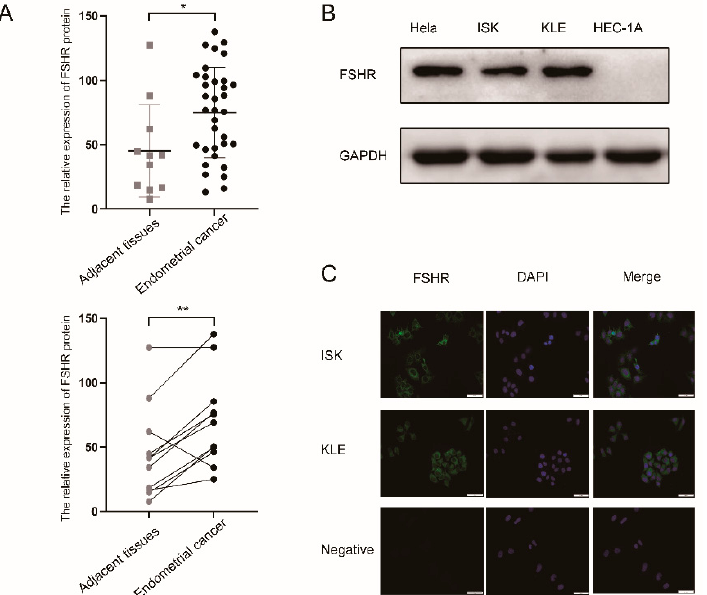
Figure 1. Expression of FSHR in EC tissue and cell lines. ( A ) Detection of the expression of FSHR in EC tissues and adjacent tissues by IHC. In the formula Histochemistry scores = ∑ ( PI × I ) , PI is the proportion of positive cells among all cells in the section and I corresponds to the color intensity of a section. ( B ) FSHR was detected by Western blot (WB) in the Hela cell line, as well as the ISK, KLE, and HEC-1A cell lines, and they were normalized with GAPDH. ( C ) The expression of FSHR in KLE and ISK was detected by IF. * p < 0.05, ** p < 0.01.